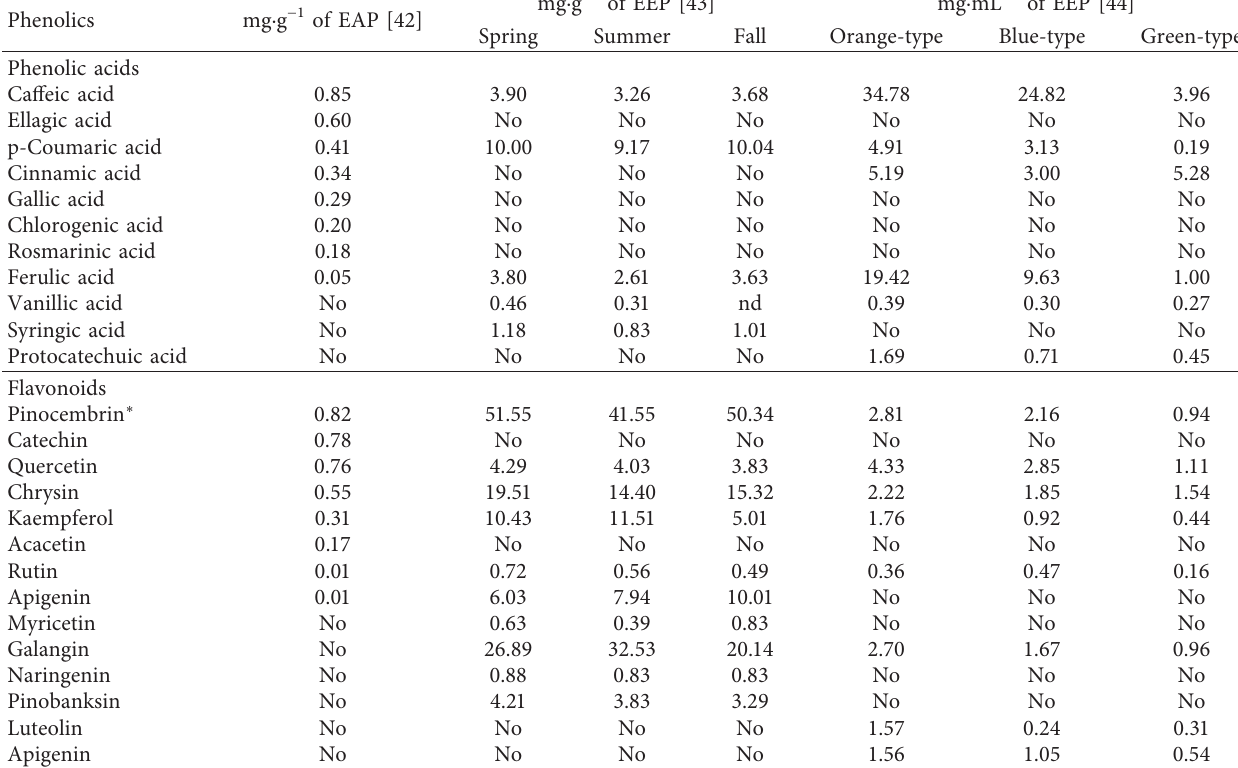
Table 1: Phenolic compositions of different propolis derivates from different plant sources, seasons, and types.